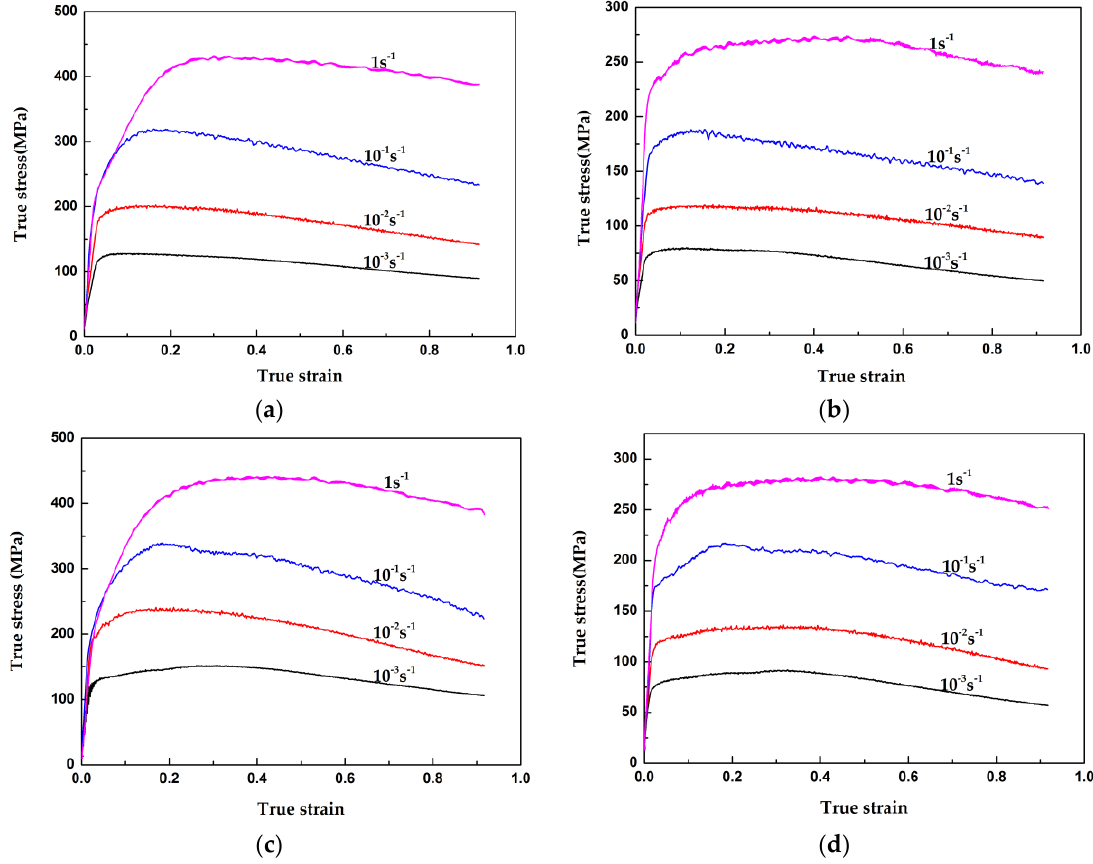
Figure 3. True stress–true strain plots at different strain rates and deformation temperature of ( a ) 900 °C and ( b ) 1000 °C for the as-cast state and ( c ) 900 °C and ( d ) 1000 °C for the homogenized state Al 0.5 CoCrFeNi HEAs.